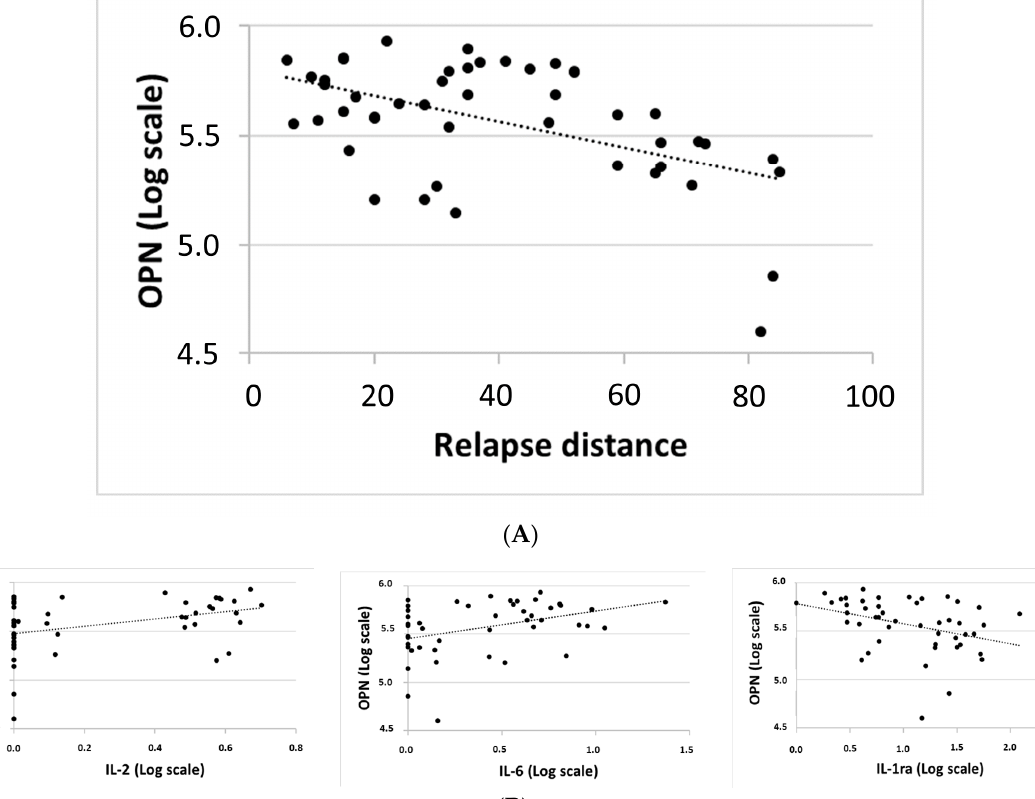
pontin. ( B) Correlation between osteopontin and CSF cytokines. Abbreviations: CSF, cerebrospinal fluid; IL, interleukin; IL-1ra, IL-1 receptor antagonist; OPN,